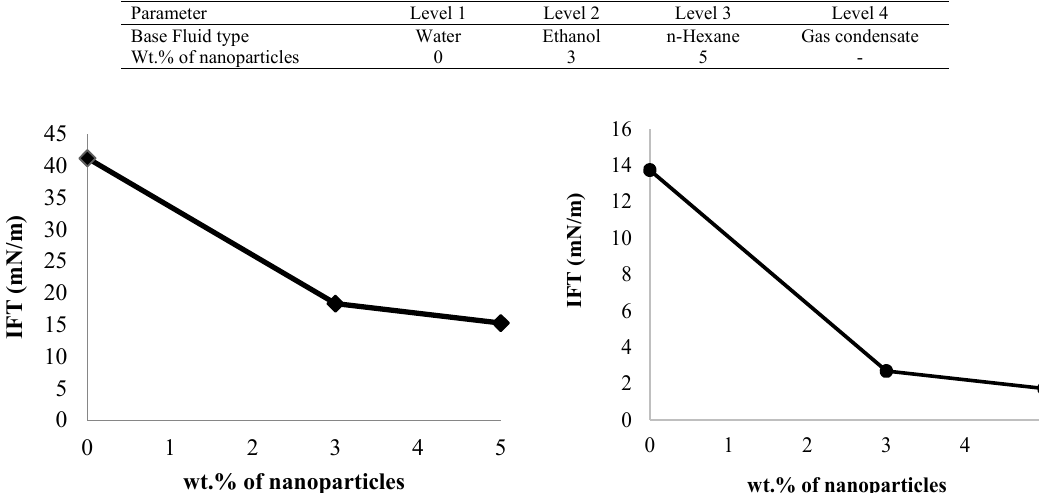
Fig. 3. IFT reduction versus wt.% of silica nanoparticle in water Fig. 4. IFT reduction versus wt.% of silica nanoparticle in